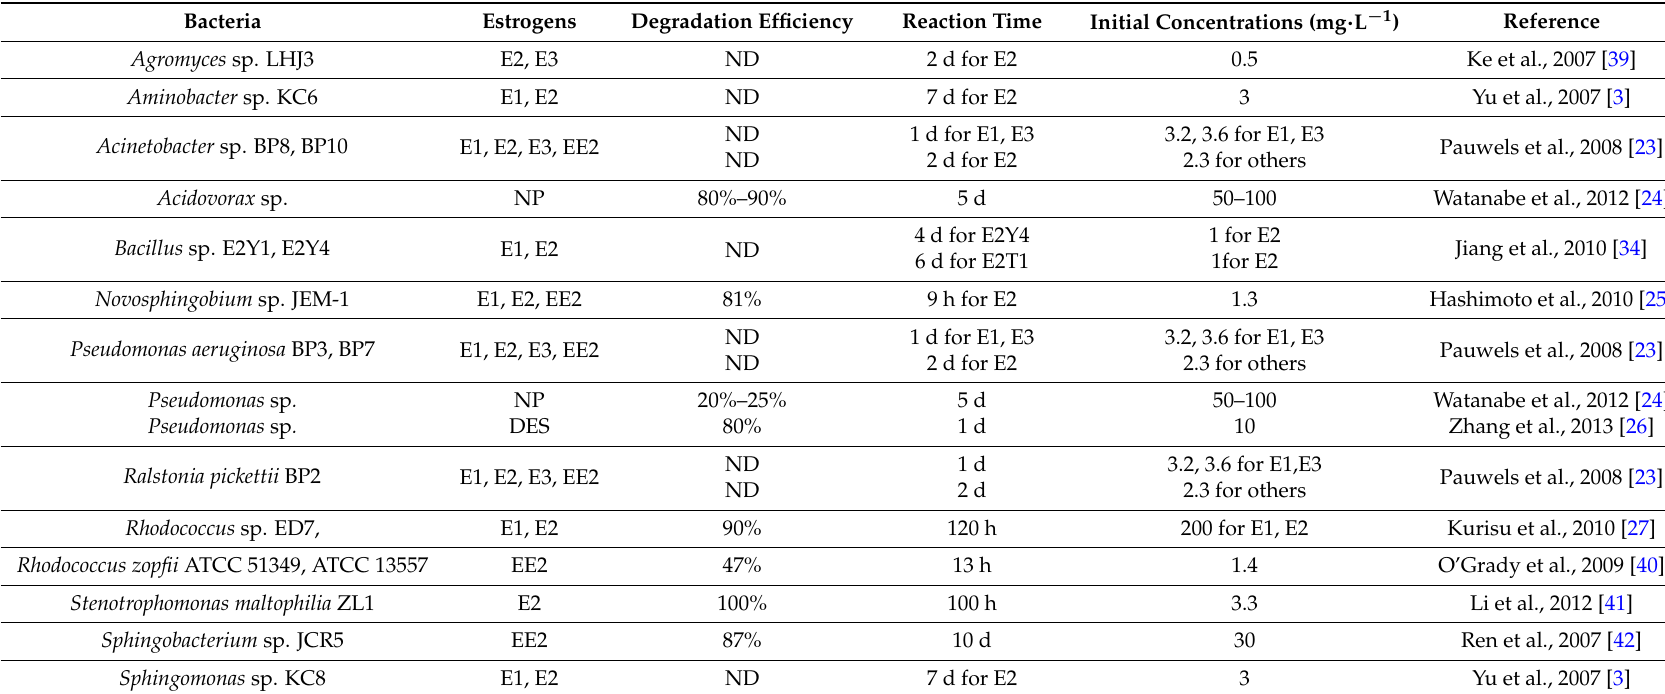
Table 2. Partial list of estrogen-degrading bacteria isolated since